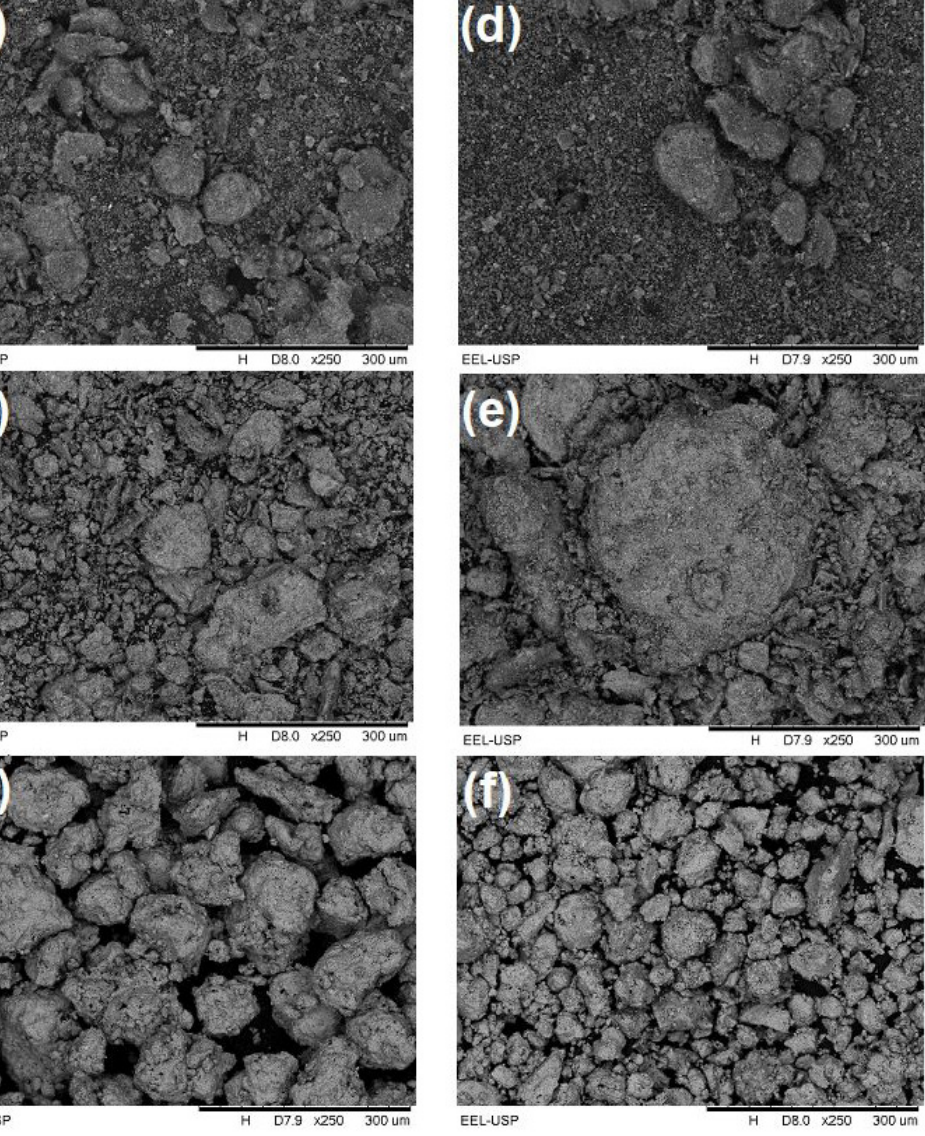
Figure 2. SEM micrographs of the (a-c) Ti-2Co-22Si-11B and (d-f) Ti-6Co-22Si-11B powder mixtures at different milling times: (a,d) 20 min, (b,e) 60 min, and (c,f) 300 min. Table 4. Values of D10, D50 and D90 as well as the specific surface area measured by laser diffraction experiments in as-milled Ti-Co- Si-B powders. Composition Alloy